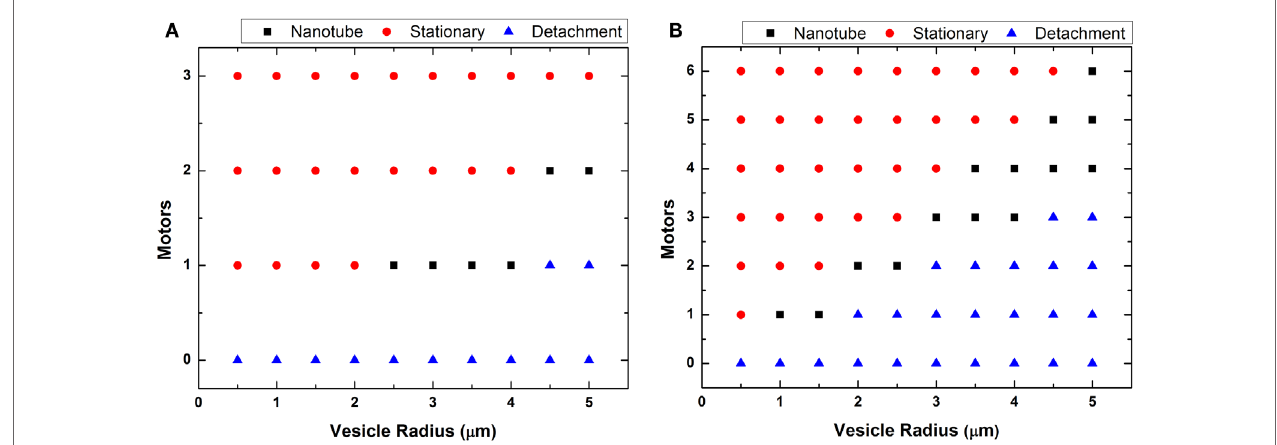
FigUre 6 | Plot of vesicle radius vs. motors . The minimum number of motors necessary to generate lipid nanotubes was estimated for each GUV radius at (a) low and (B) high flow. The calculation assumed generated nanotubes to be 67.6 nm in